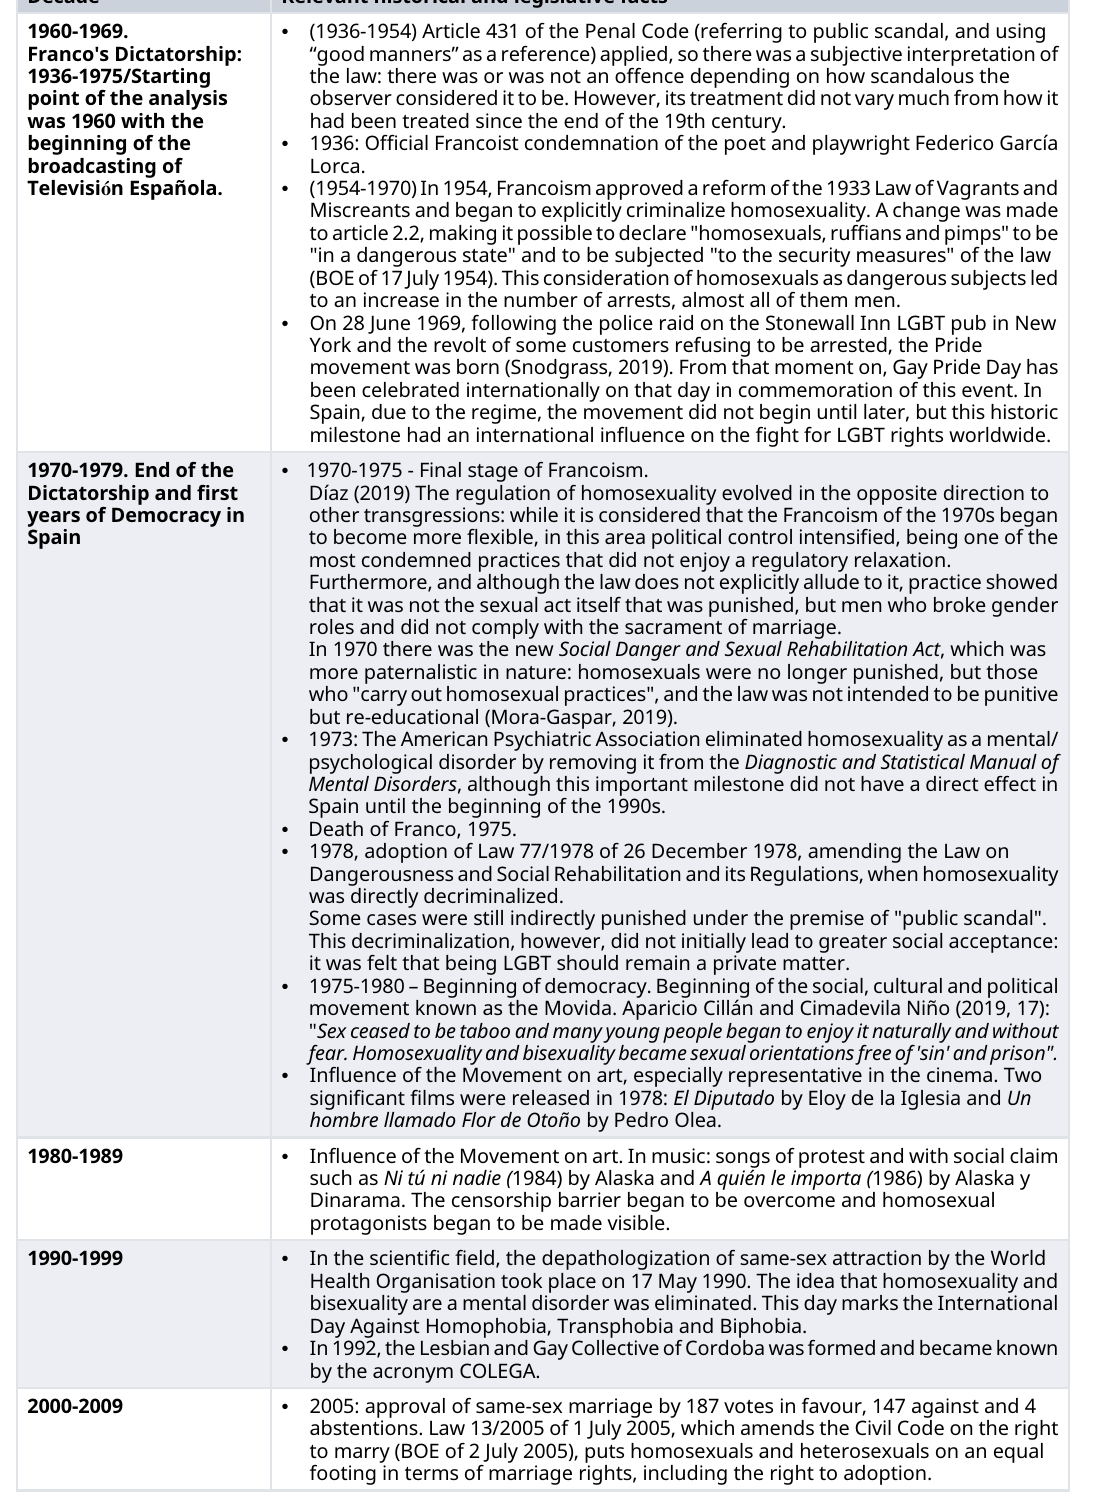
Table 3. Relevant historical and legislative